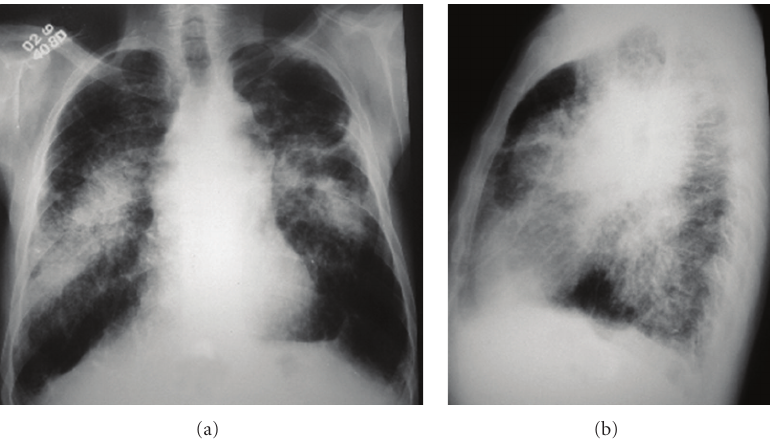
Figure 1: Chest radiographs in anteroposterior (a) and lateral (b) incidences showing bilateral perihilar conglomerate masses associated with multiple small nodules, predominantly in the upper and middle